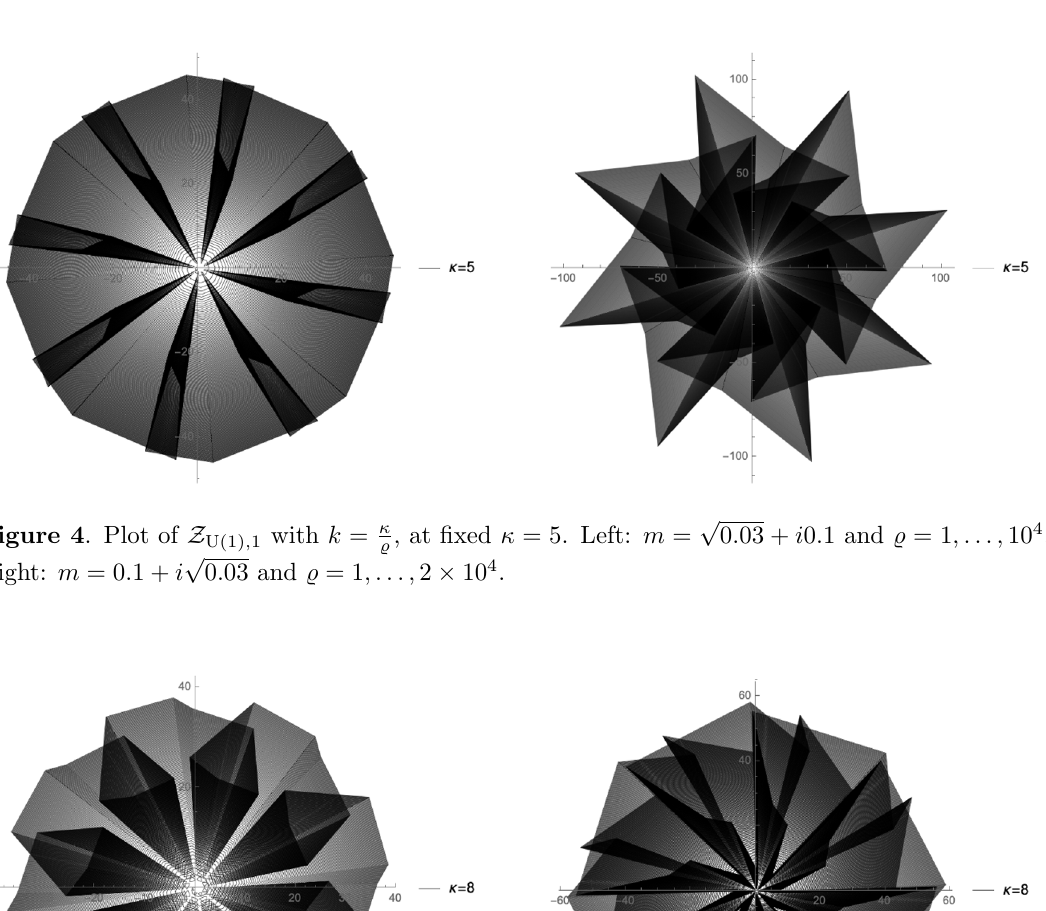
with k = (cid:20) , at (cid:12)xed (cid:20) = 8 and varying % = 1 ; : : : ; 10 4 . Left: m = U(1) ; 1 % p 0 :